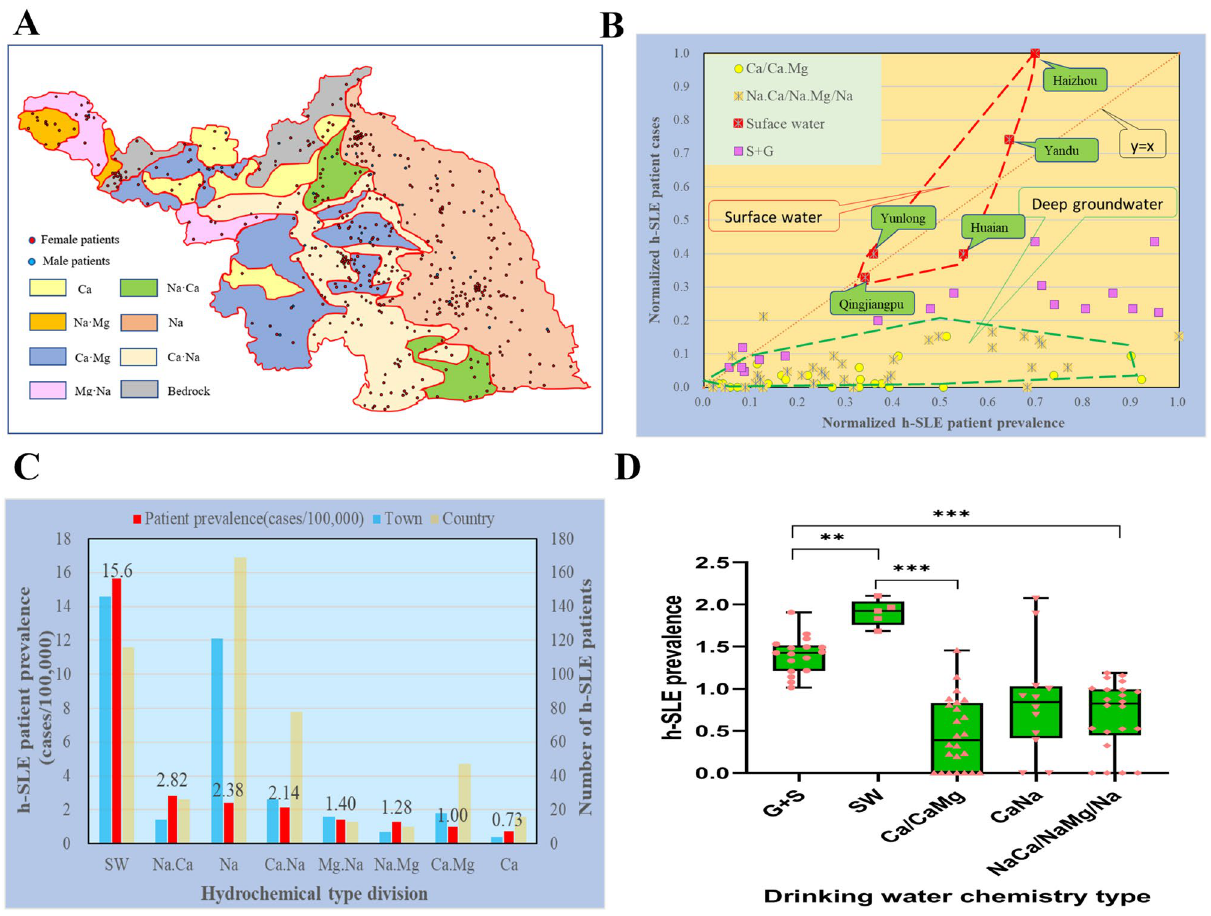
Figure 3. Relationship between the distribution of h-SLE patients and drinking water sources. ( A ) Distribution of groundwater chemistry types (2000s) and h-SLE patients in northern Jiangsu (prepared by WQ in Microsoft Excel 2019, referring to the cation distribution map of hydrochemical facies for the phreatic aquifer in the 2000s in the paper, https:// doi. org/ 10. 1007/ s12665- 015- 4575-4). ( B ) Normalized relationship between the prevalence of h-SLE patients and the cases of h-SLE in different drinking water sources in northern Jiangsu. ( C ) Prevalence distribution of h-SLE patients with different chemical drinking water sources in Northern Jiangsu. ( D ) Significant difference analysis of the prevalence of h-SLE patients in water chemistry type. The prevalence of h-SLE patients conformed to the normal distribution after BOX-COX conversion (λ = 0.053) and Shapiro–Wilk Test (P value: 0.186 > 0.05). Statistical analysis was performed with one-way ANOVA. **P < 0.01, ***P <